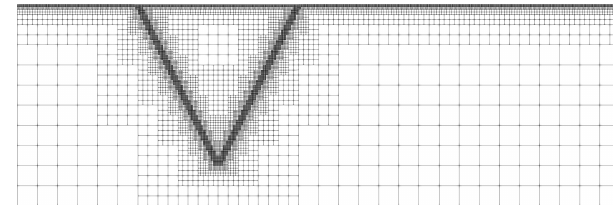
Figure 12. Adaptively refined grid for the first time step of the sim- ulation. We can see that the grid is refined to a high level near the faults, where the velocity gradient is high. On the contrary, it is coarsened where the velocity has small gradients, particularly in the lower right and left corners.